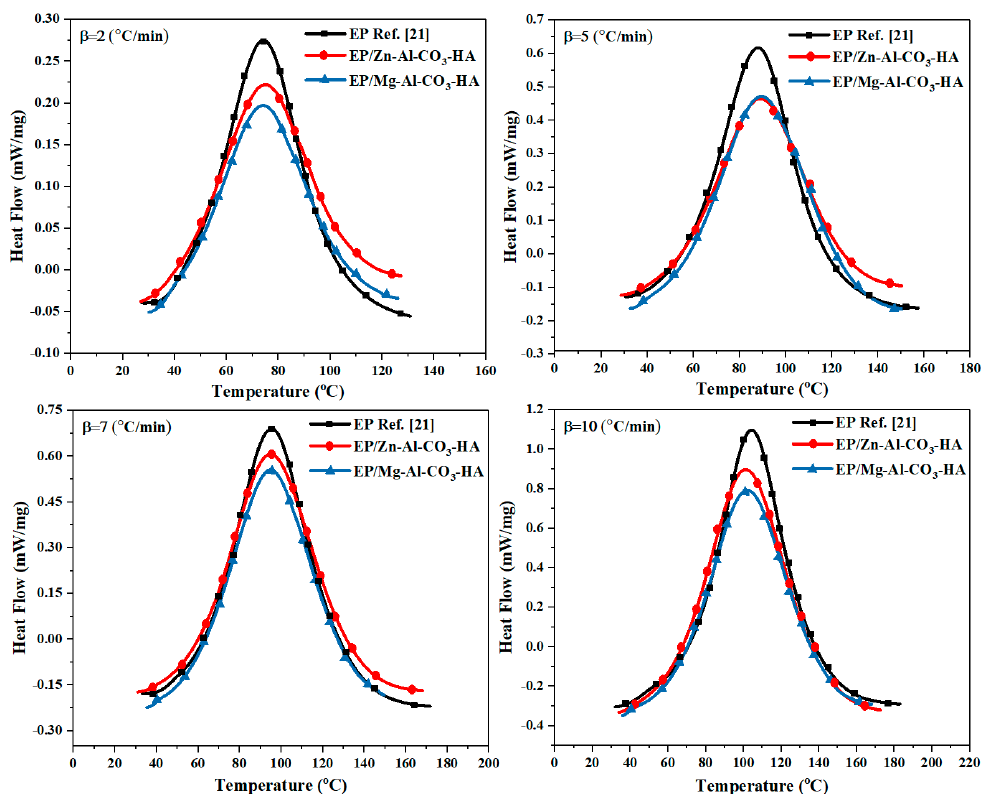
Figure 4. Dynamic differential scanning calorimetry (DSC) thermograms of EP [21], EP/Zn-Al-CO 3 -HA, and EP/Mg-Al-CO 3 -HA at different heating rates.